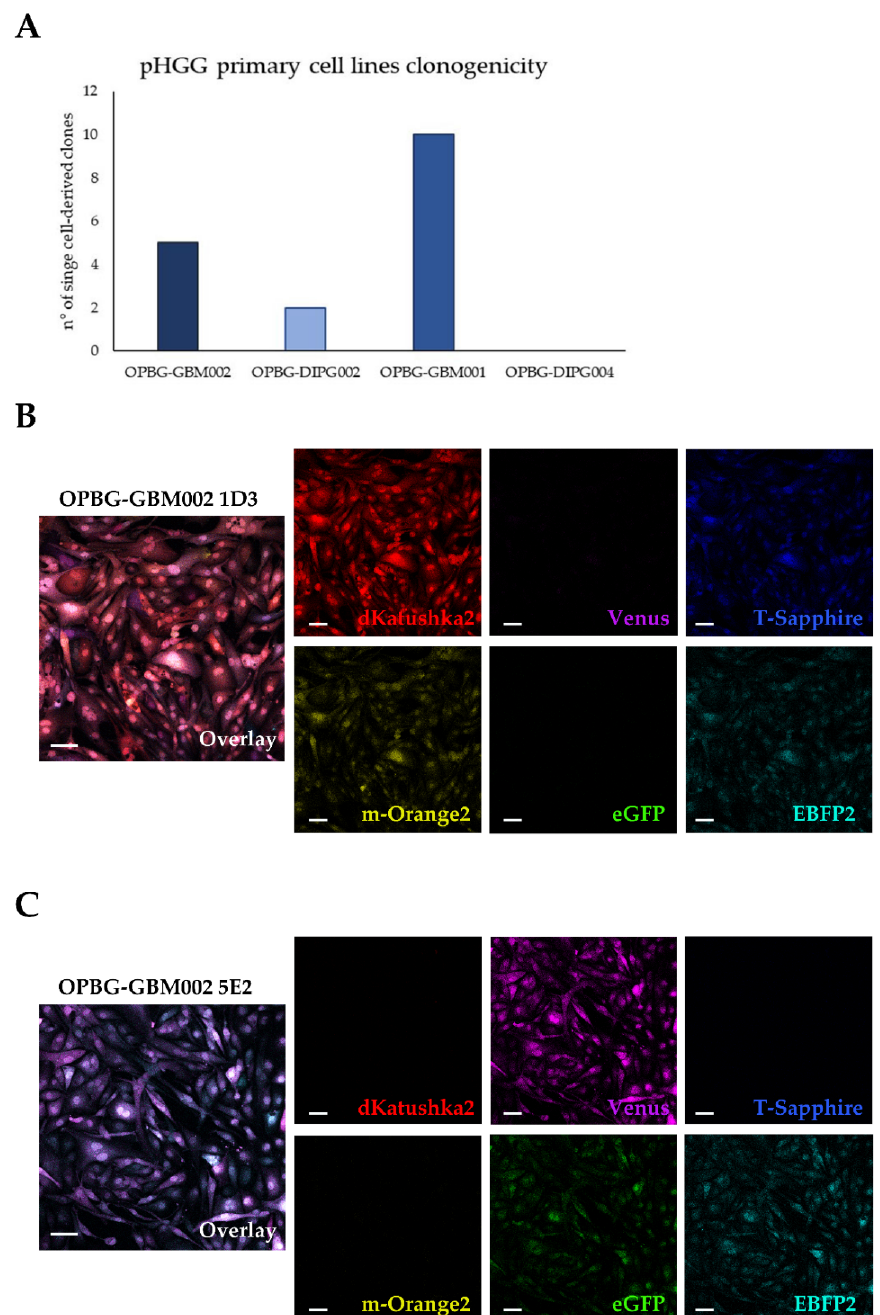
Figure 5. pGBM and DIPG optical barcoded single cell-derived clones analyzed on the confocal microscope. ( A ) Clonogenicity. The graph shows the number of single cells from which a cell line was established, under 2D laminin-adherent stem cell culture conditions, for the four multifluorescent primary patient-derived cell lines. ( B , C ) Representative fluorescent images from two OPBG-GBM002 single cell-derived clones are shown with the overlay and the splits for the six fluorescent proteins, which clearly identify the corresponding OBs for each clone: 1D3 ( B ) expressing dKatushka2 (red), m-Orange2 (yellow), T-Sapphire (blue), and EBFP2 (cyan); 5E2 ( C ) expressingVenus (magenta), eGFP (green) and EBFP2 (cyan). Fluorescent image acquisition was performed using a Leica TCS AOBS-SP8X confocal microscope. Scale bars : 10 μ m.